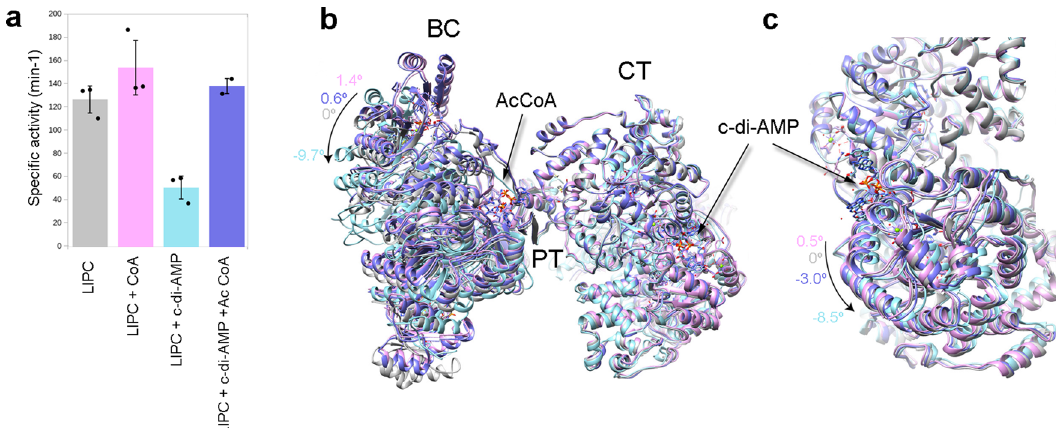
Fig. 10 | Allosteric regulation and structural changes in LlPC. a Speci fi c activity of LlPC in the absence and presence of allosteric regulators acetyl-CoA and c-di- AMP. Data are presented as mean values (bars) and SD (error bars), and dots representeachindependentassaywith n =3forallthesamplesbutLlPCwithacetyl- CoA and c-di-AMP with n =2. Source data are provided as a Source Data fi le. b Structural comparison of LlPC apo (pdb code 5VYW), with acetyl-CoA (current work), with c-di-AMP (pdb code 5VYZ) and with acetyl-CoA and c-di-AMP (current